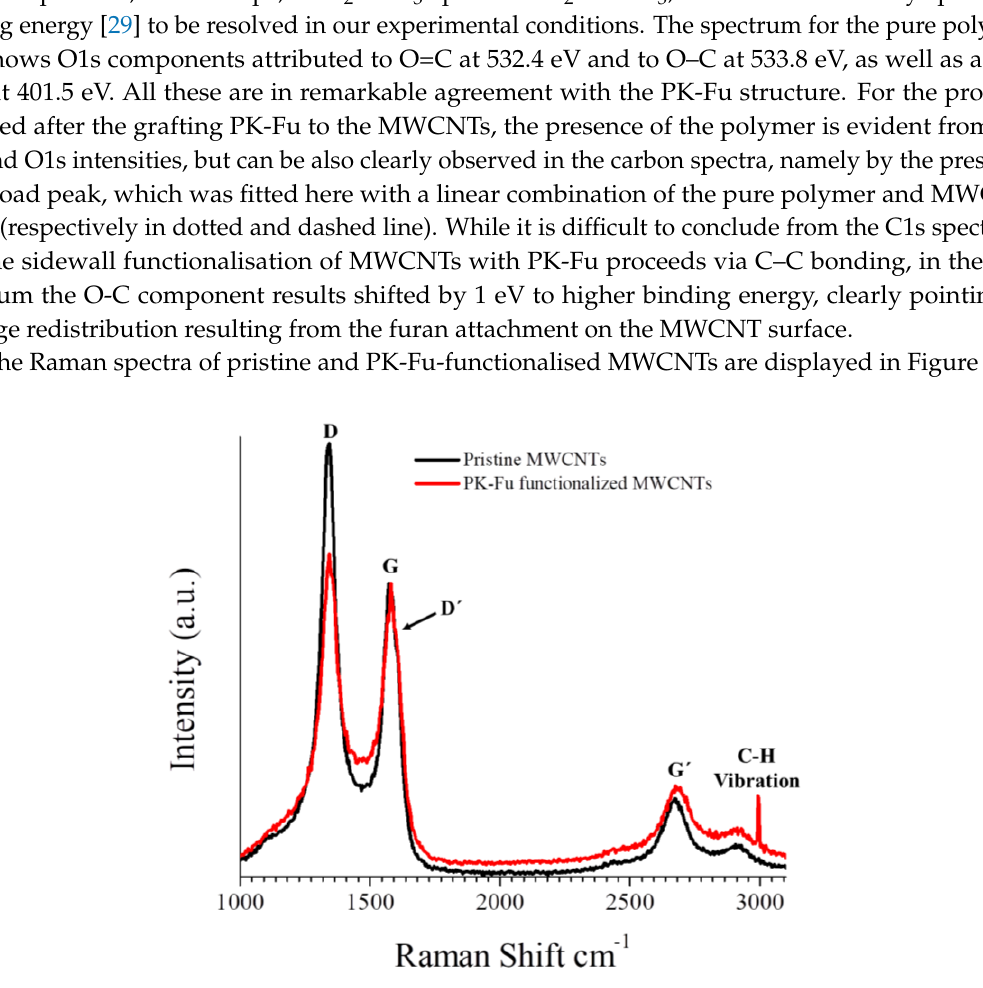
Figure 4. Raman spectra (normalised at the G band, 1580 cm −1 ) of pristine and PK-Fu-functionalised MWCNTs.